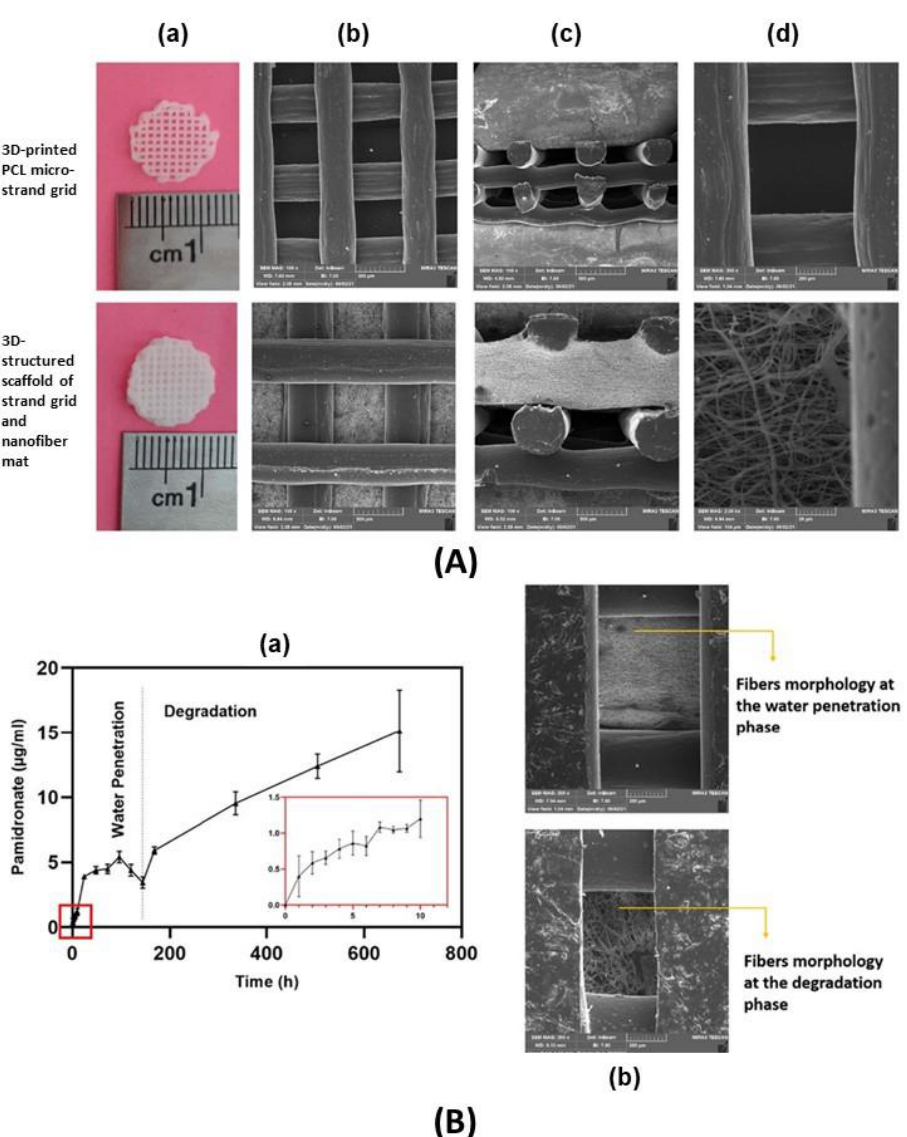
Figure 20. ( A ) Structural characterization of the PCL-based scaffolds: ( a ) macroscopic images; ( b ) top view (scale bar: 500 µ m), ( c ) cross-sectional view (scale bar: 500 µ m), and ( d ) top view of a pore of a 3D-printed grid (scale bar: 200 µ m), and electrospun nanofibers (scale bar: 20 µ m); ( B ) In vitro drug release: ( a ) cumulative release of Pam and ( b ) images of PCL/LDH-Pam fibers in the scaffold at the water penetration and degradation phases (scale bar: 200 µ m), after 28 days of immersing in PBS solution (reprinted from Belgheisi et al. [280] with permission of Elsevier).